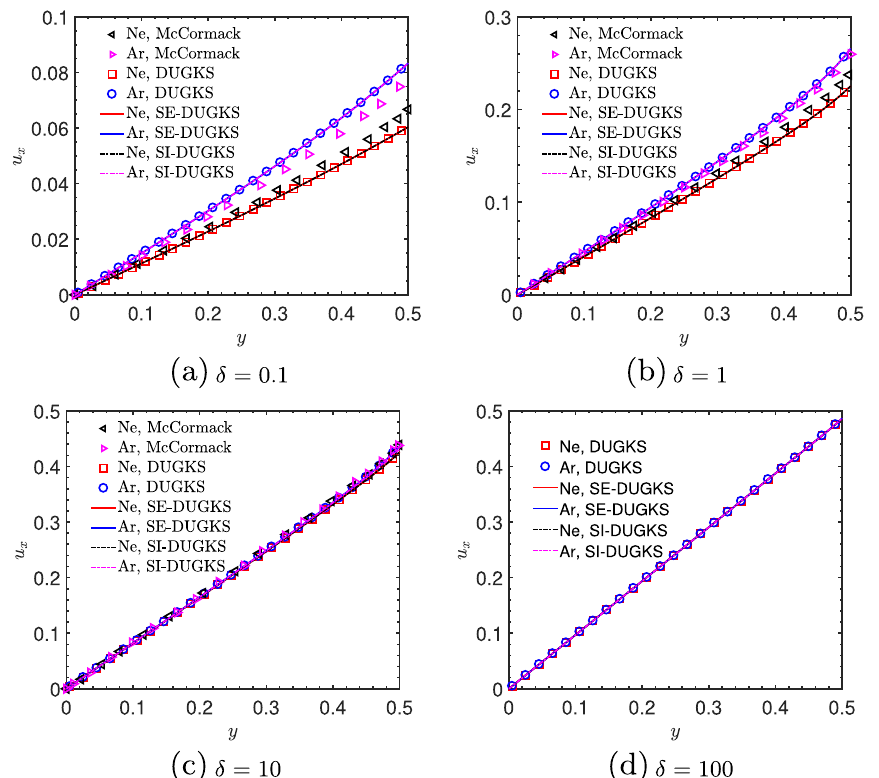
Fig. 12 Velocity profiles in the Couette flow for the Ne-Ar mixture with C 0 =